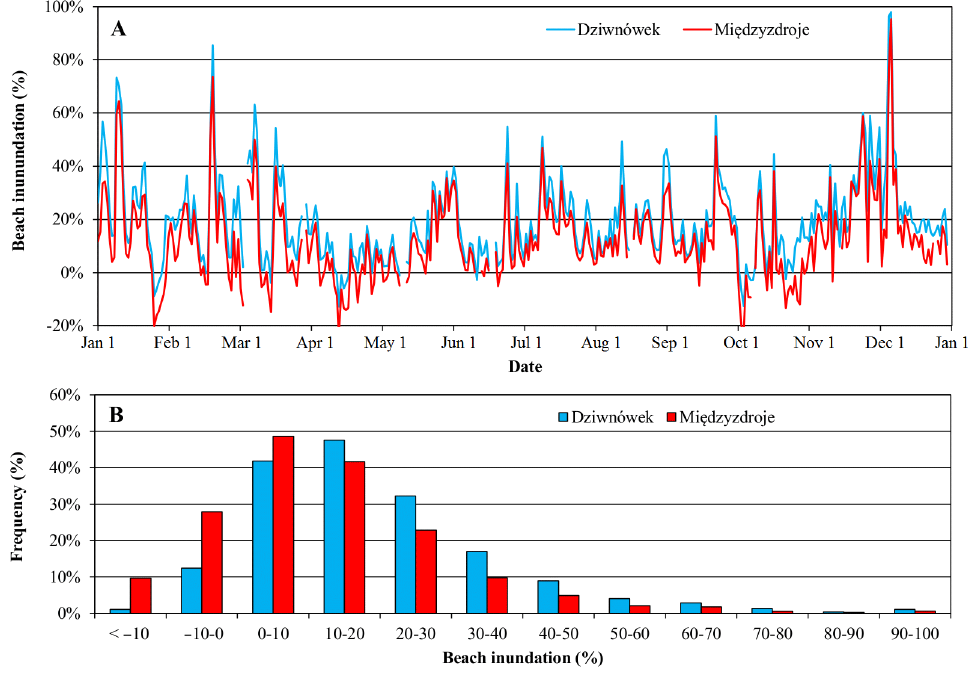
Figure 6. Extreme 2% beach inundation estimates for Mie˛dzyzdroje and Dziwno´wek, hourly data from January 1 st to December 31 st , 2013. Daily averages (A) and histogram (B).